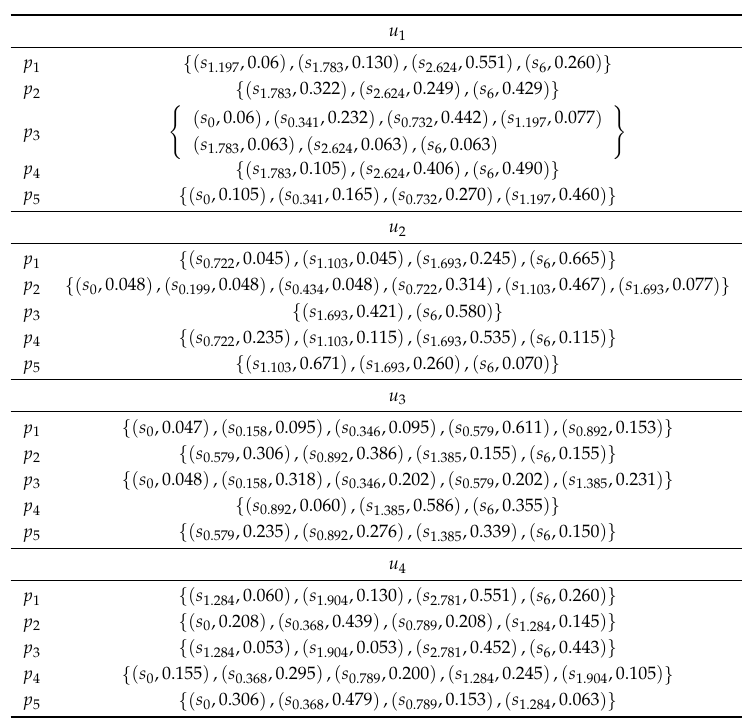
Table 5. Re-generated PHFLTS-represented group evaluation matrix ( R =